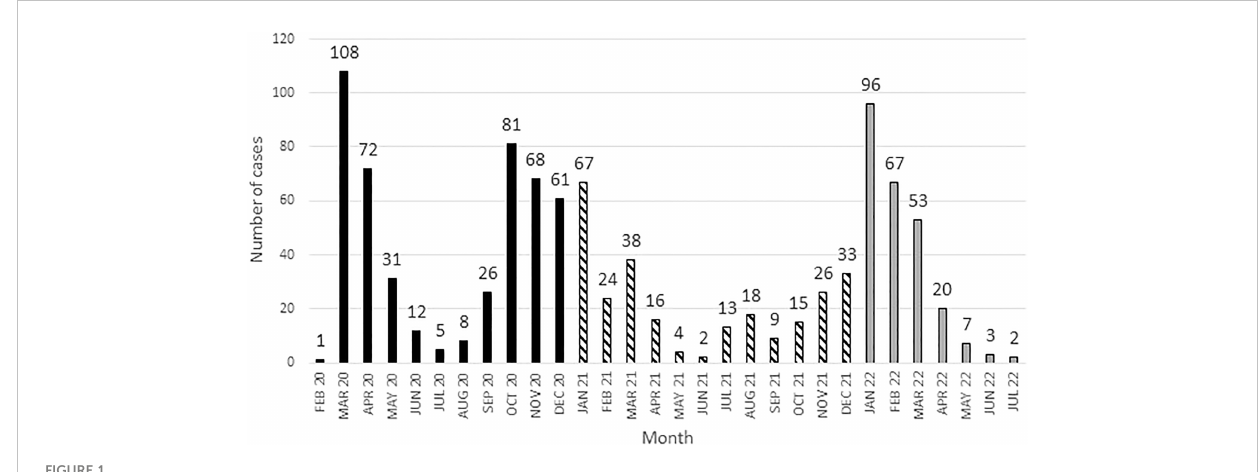
FIGURE 1 Distribution of cases over